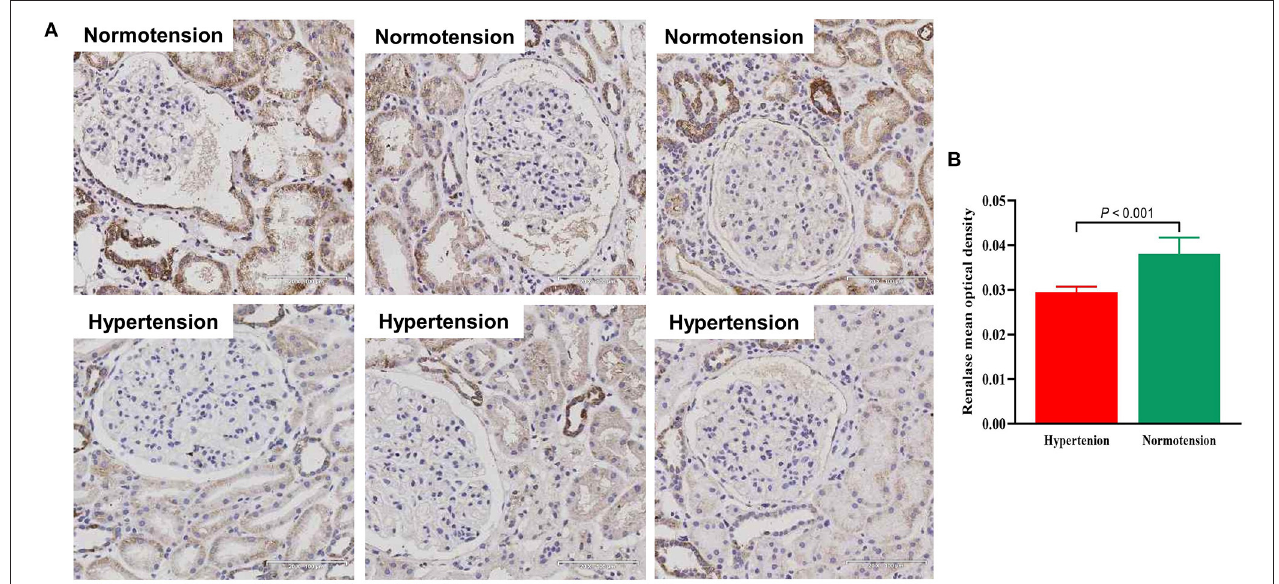
FIGURE 3 | (A) Representative photomicrographs of renalase expression in human renal biopsy visualized by immunochemistry staining in normotensive group and hypertensive group (x200). (B) Bar graph showing quantitative analysis of renalase. Student’s t -test was used to determine statistical differences between two